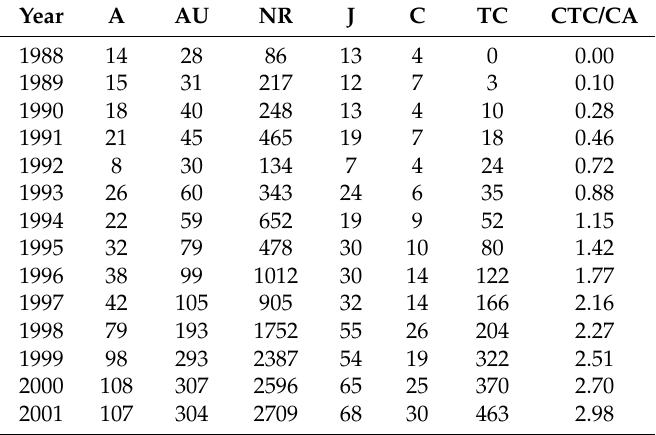
Table 1. Major characteristics of the articles published on mine waste